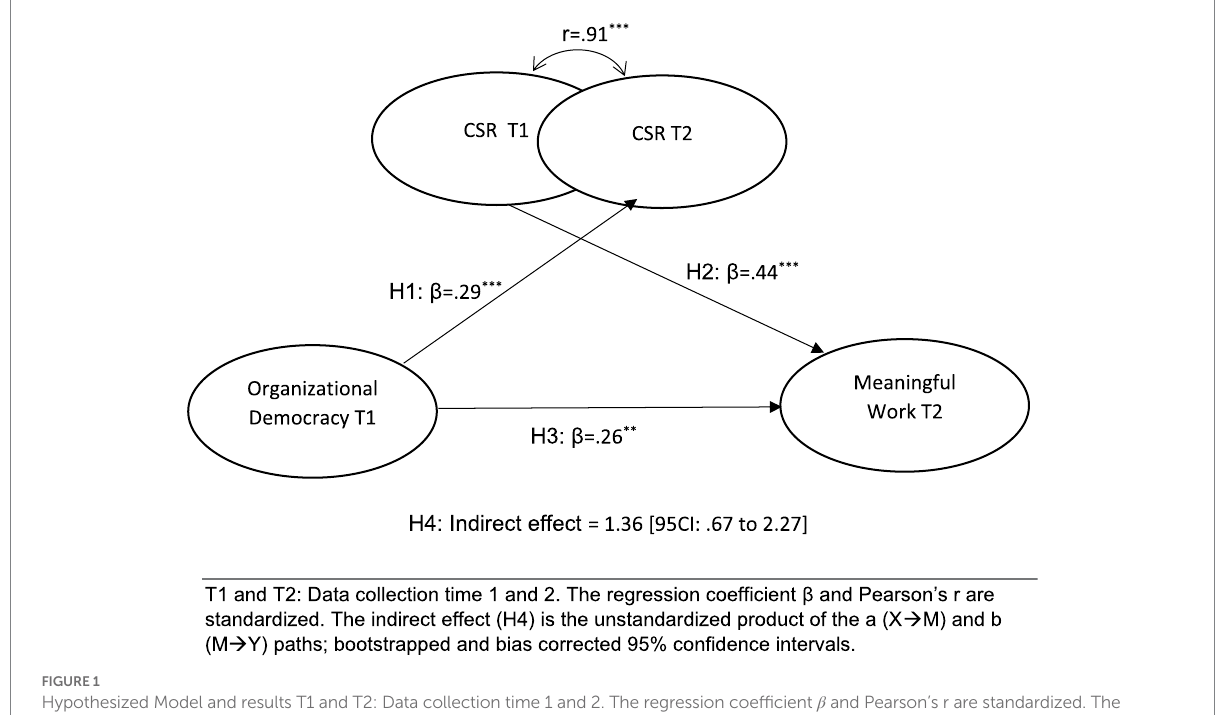
FIGURE 1 Hypothesized Model and results T1 and T2: Data collection time 1 and 2. The regression coefficient β and Pearson’s r are standardized. The indirect effect (H4) is the unstandardized product of the a (X → M) and b (M → Y) paths; bootstrapped and bias corrected 95% confidence